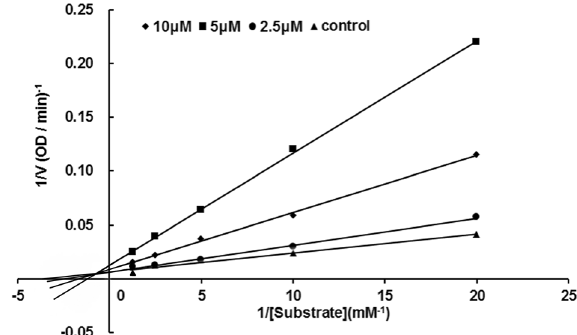
Figure 2. Lineweaver–Burk plots of 8c on BChE.